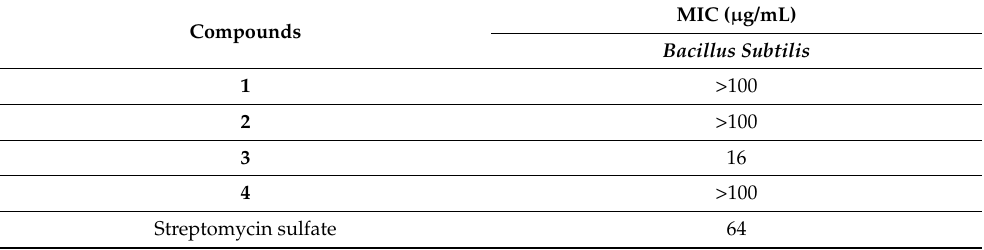
Table 4. Antibacterial potencies of compounds ( 1 – 4 ) against Bacillus subtilis .